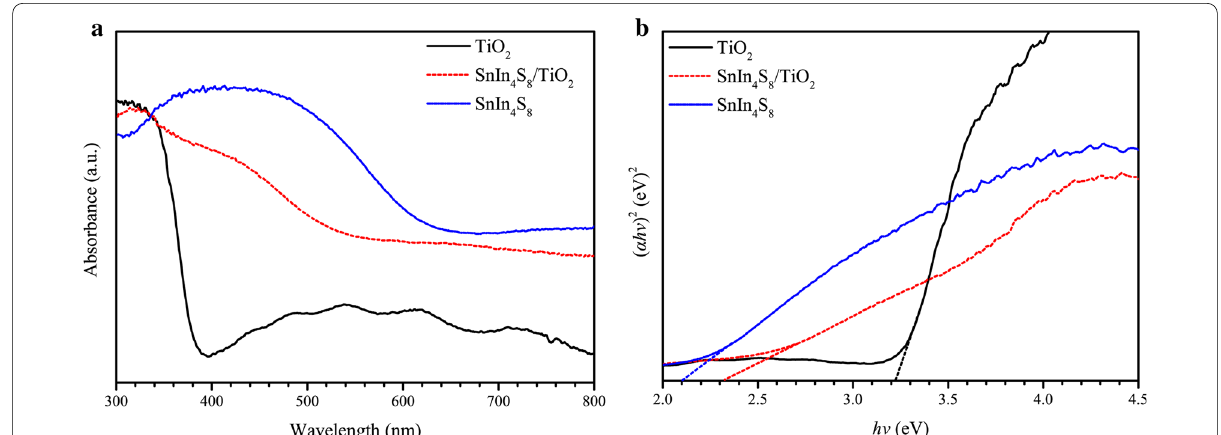
Fig. 6 UV–visible diffuse reflectance spectra of TiO 2 , SnIn 4 S 8 , and SnIn 4 S 8 /TiO 2 composite